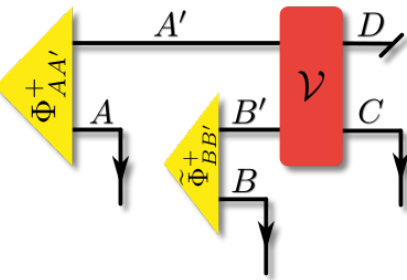
Figure 14: Circuit that leads to Υ